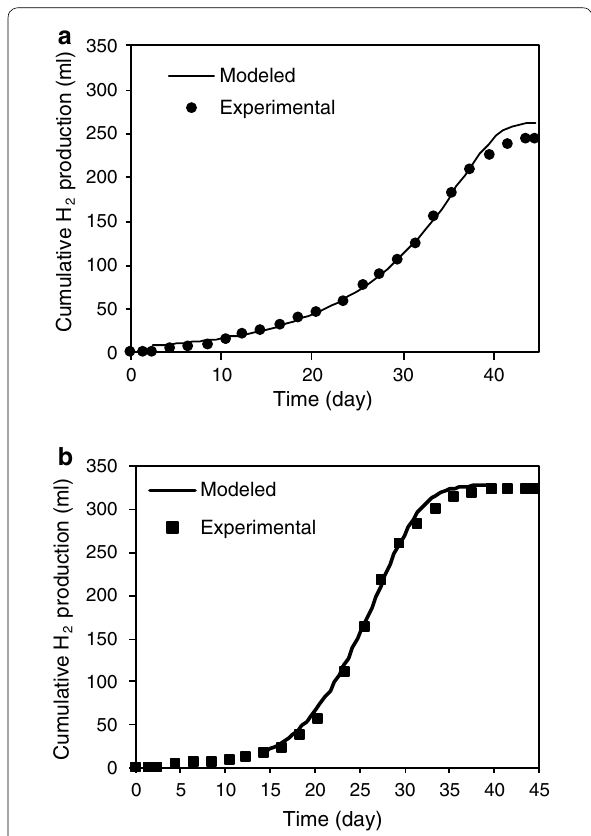
Fig. 5 Experimental and modeled H 2 profiles for a mono‑culture and b